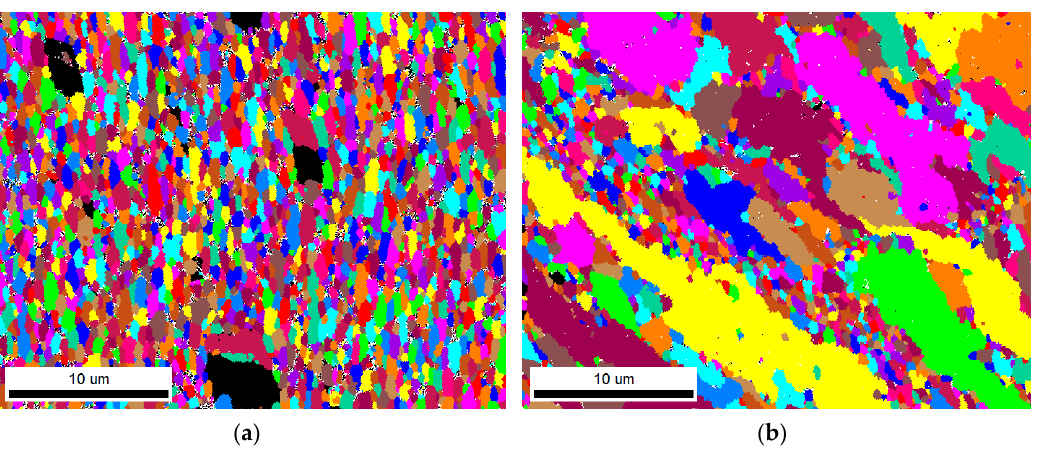
Figure 13. The unique grain color maps of the material after the EC process (LR plane): ( a ) bottom surface region; ( b ) central region.